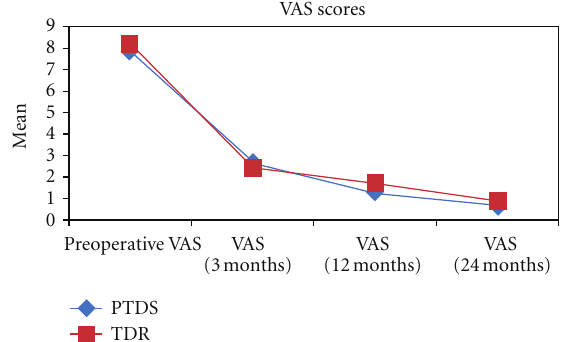
F 6: e distribution of VAS scores for both groups.